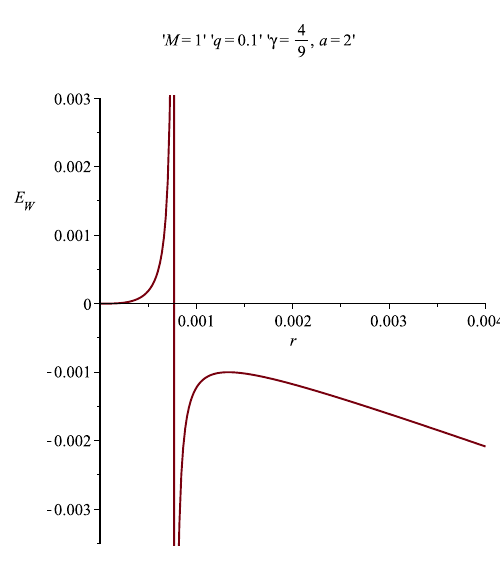
Figure 5. Weinberg energy versus the radial distance r .